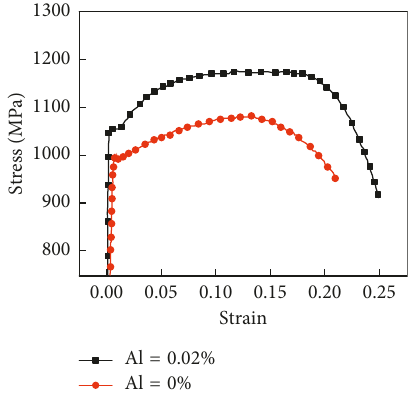
Figure 2: Hardening curves in tensile tests with the content of